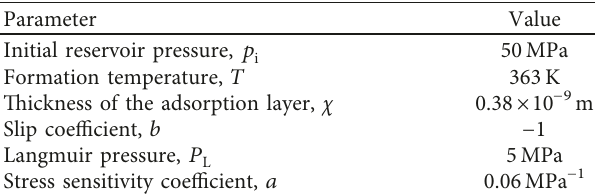
Figure 10: The distribution of pressure on the gas reservoir profile after Table 3: Basic parameters for the seepage model.